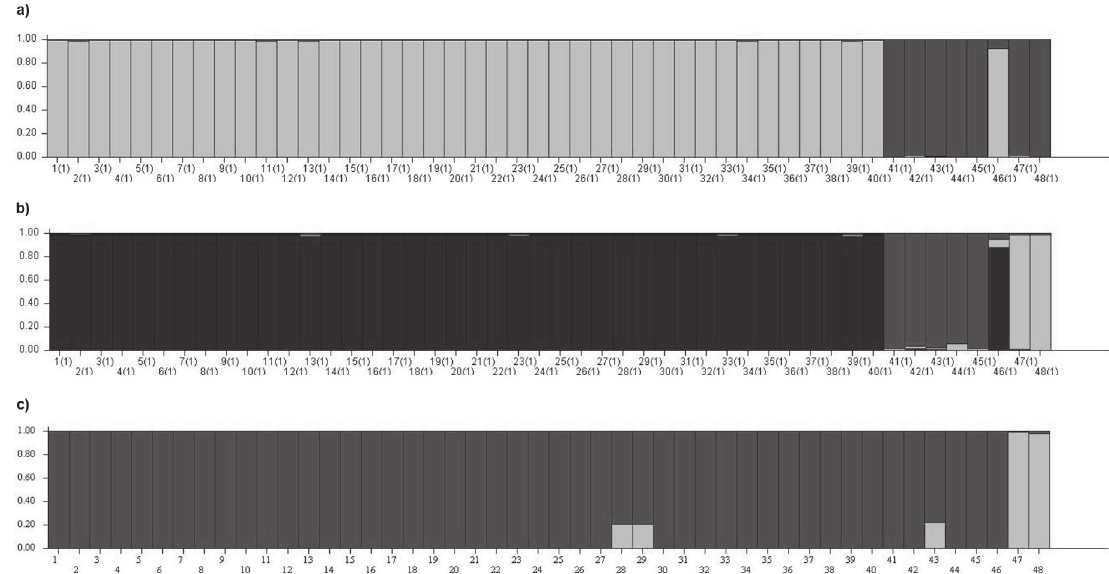
Figure 2 - Structure grouping of 48 jatropha accessions. ( a ) based on 11 SSR profiles and delta k = 2; ( b ) based on 11 SSR profiles and delta k = 3; ( c ) based on 5 ISSR profiles and delta k = 2; The vertical axis comprehend the relative membership coefficient and the horizontal axis the individual identification according to Table